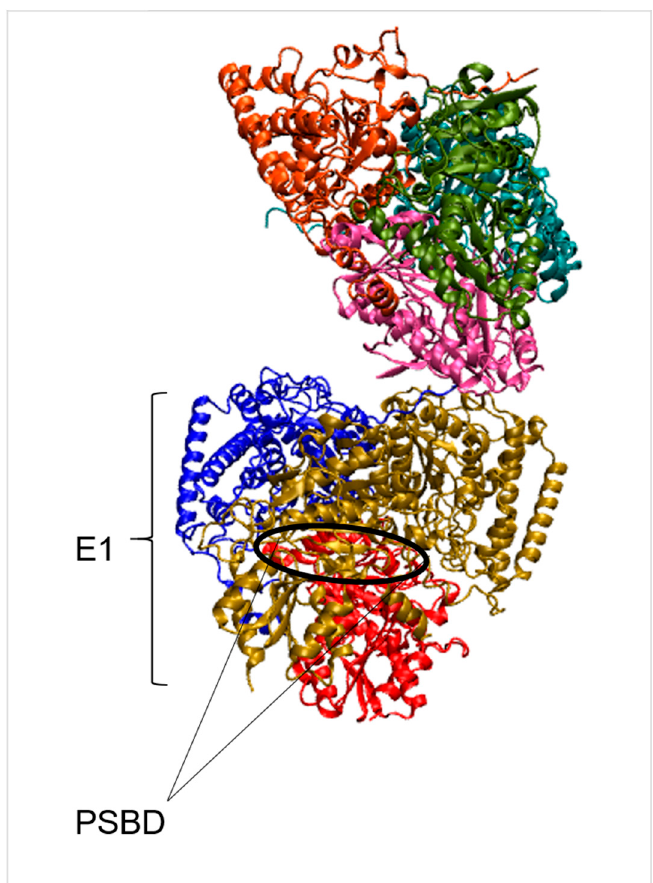
Figure 3. Crystal structure of branched-chain keto-acid dehydrogenase catalyzing oxidative decar- boxylation (PDB: 2BP7). The different colors indicate the different chains. While the black circle rep- resents the position of the PSBD.